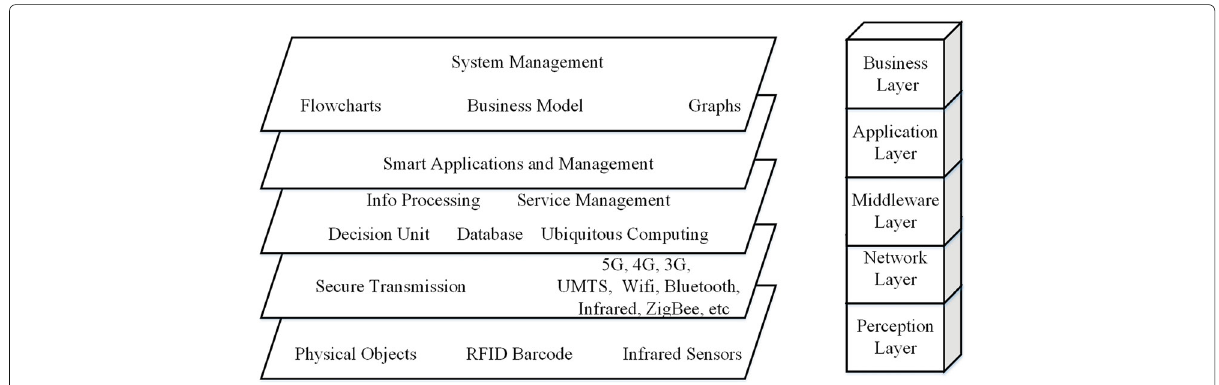
Fig. 2 The general architecture for the IoT. The general architecture for the IoT, which consists of five layers according to